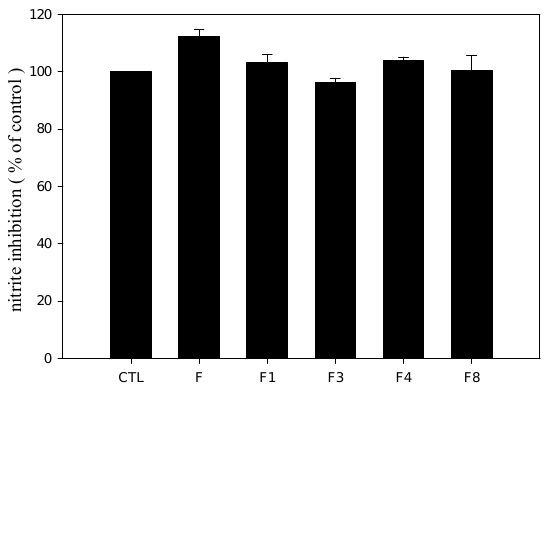
264.7 cells. Nitrite was measured using Griess reaction at 24 h after treatment with LPS (100 ng/ml) in the presence or absence fenbufen and its amide analogs (10 μ M). All data were presented as the mean ± S.D. of four independent experiments. CTL, control;